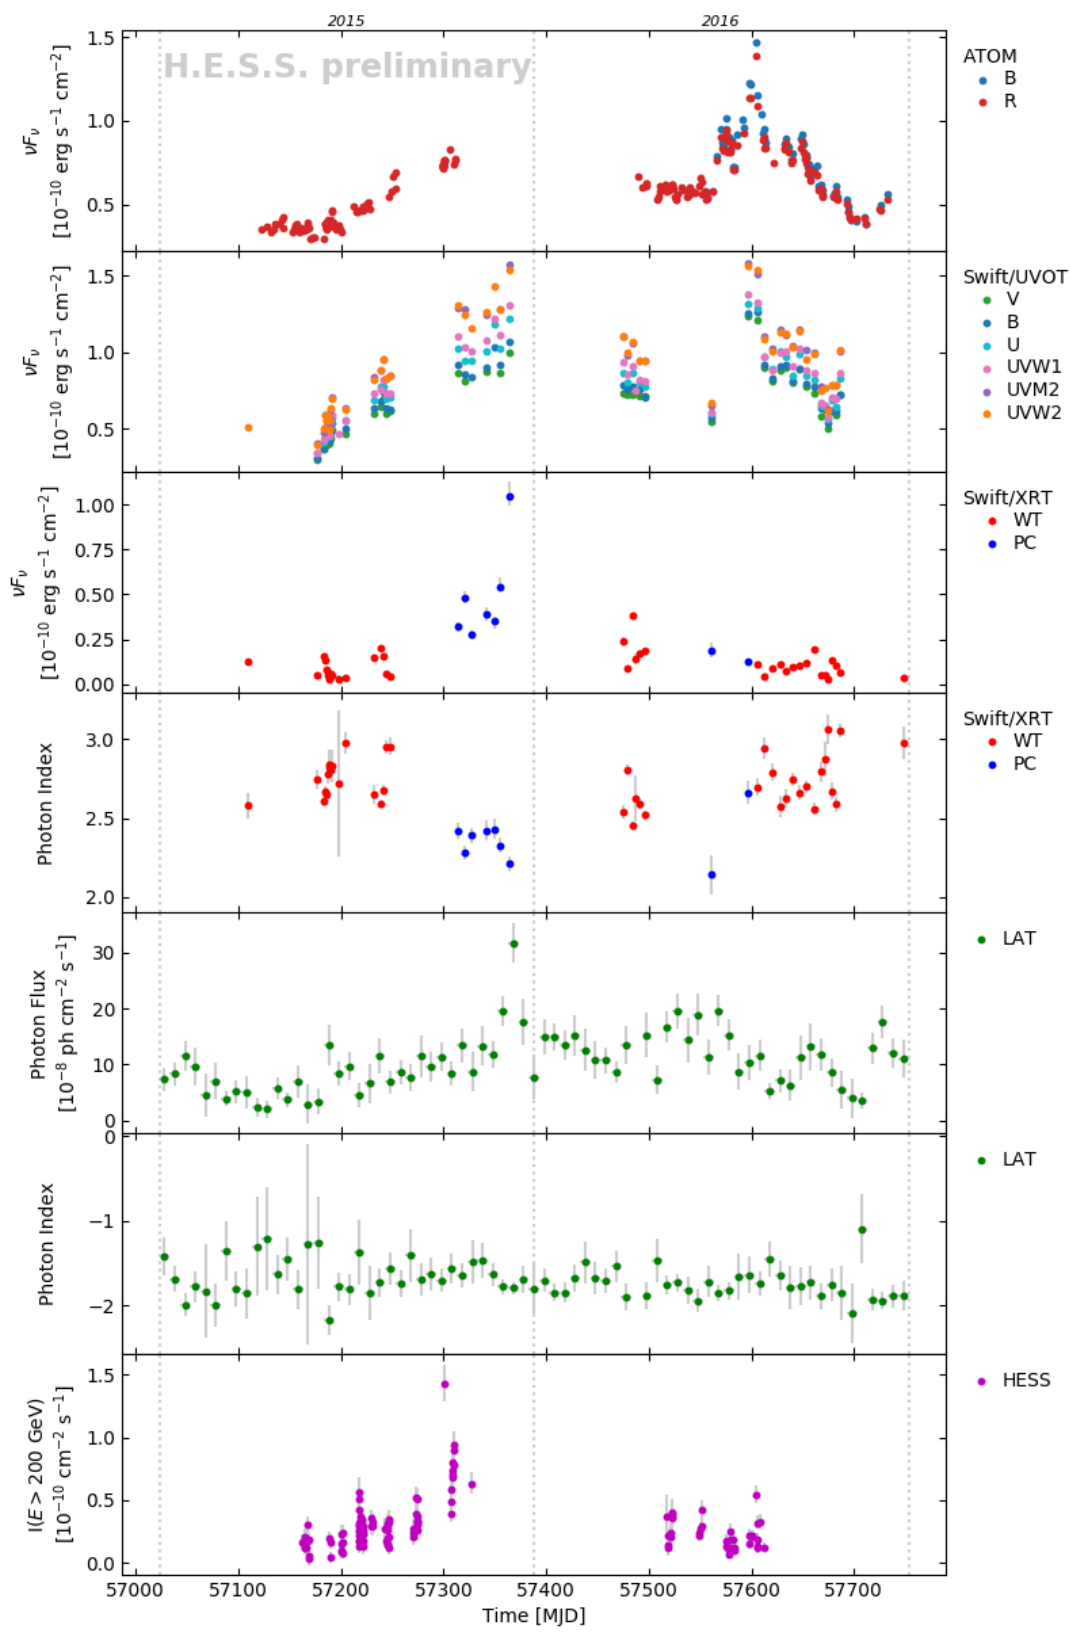
Figure 1. Multiwavelength light curve of PKS2155-304 presenting data collected in 2015–2016 with ATOM, Swift-UVOT, Swift-XRT, Fermi-LAT and